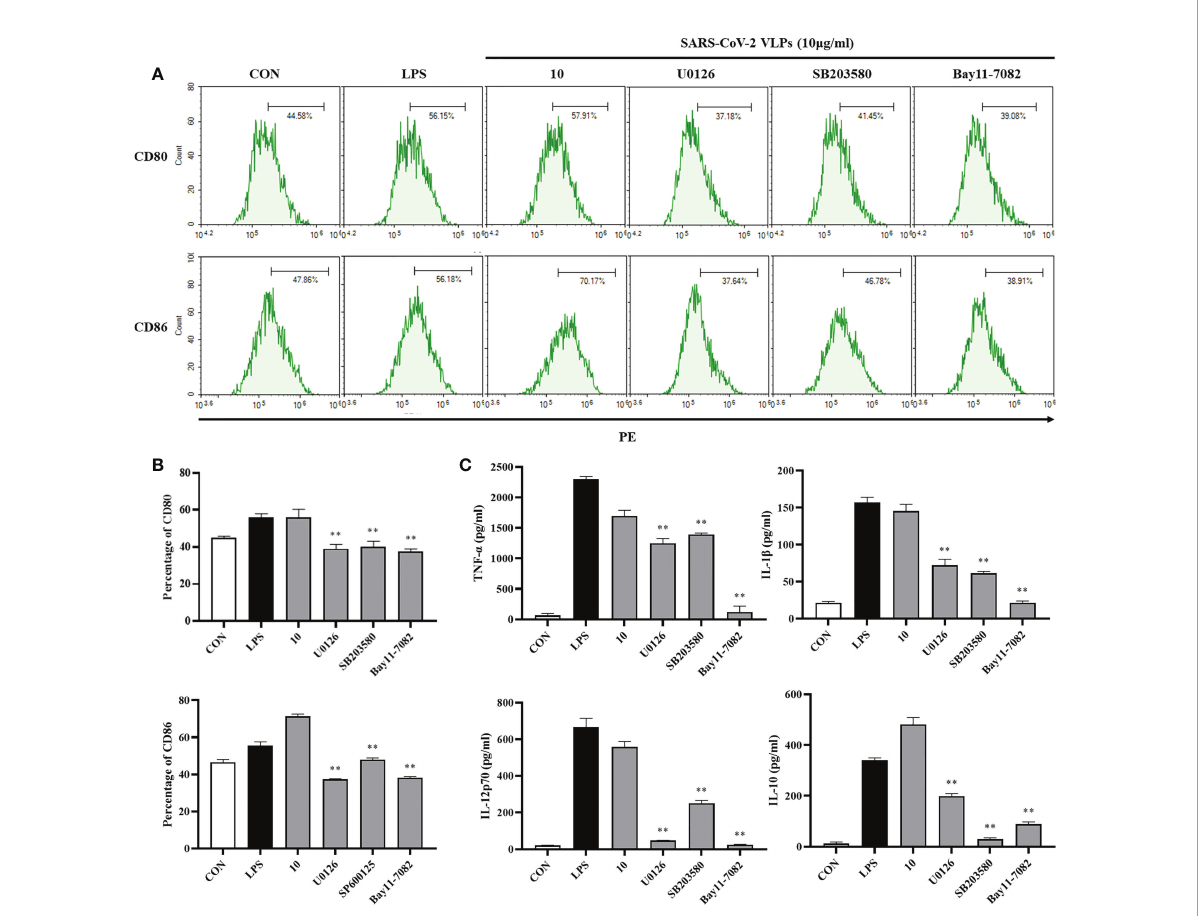
FIGURE 5 Involvement of the MAPK signaling pathways in SARS-CoV-2 VLP-induced DC maturation. DCs were treated with the pharmacological inhibitors of ERK1/2 (U0126, 10 M), p38 (SB203580, 20M), NF- k B (Bay11-7082, 20 M), or DMSO (control) for 1 h prior to stimulation with 10 m g/mL SARS- CoV-2 VLPs for 24 h (A, B) DCs were stained with anti-CD80 and anti-CD86 antibodies, and the expression of CD80 and CD86 was analyzed using fl ow cytometry. (C) Culture supernatant concentration of TNF- a , IL-1 b , IL-12p70, and IL-10 were measured via ELISA. Values are the means ± SE of three independent experiments. ** P < 0.01 versus SARS-CoV-2 VLPs-treated groups (10 m